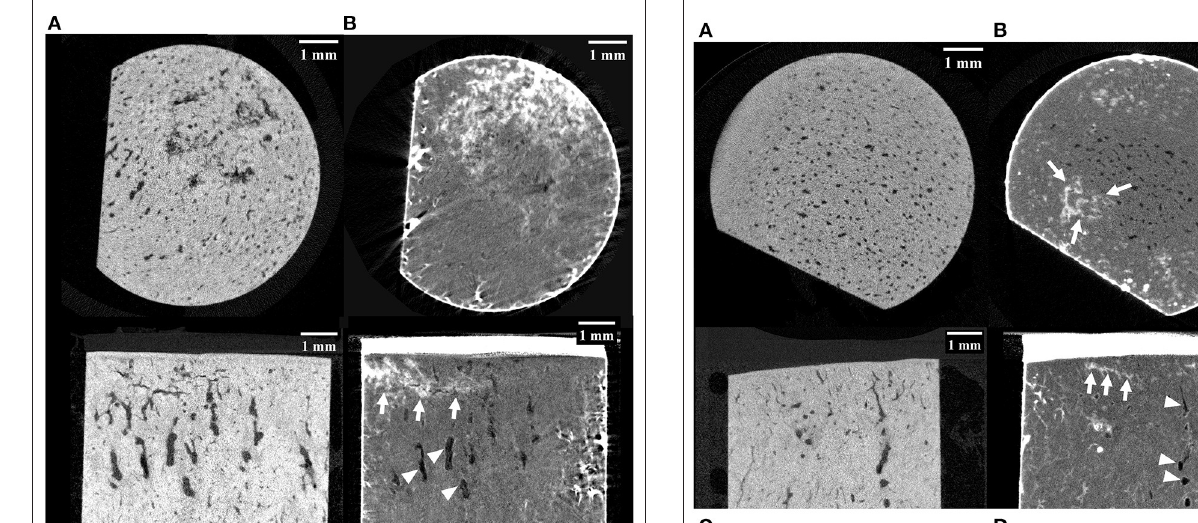
to the palmar MCIII and proximal sesamoid sites at all layers of bone: total, superficial, and deep ( p < 0.05; Figure 4